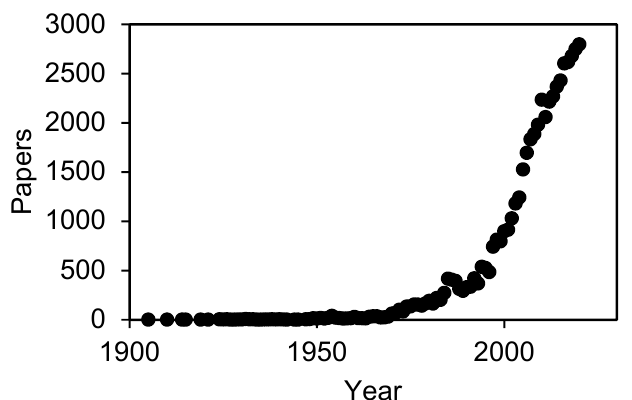
Figure 1. Number of papers published related to “electrodeposition” appearing in either abstract,